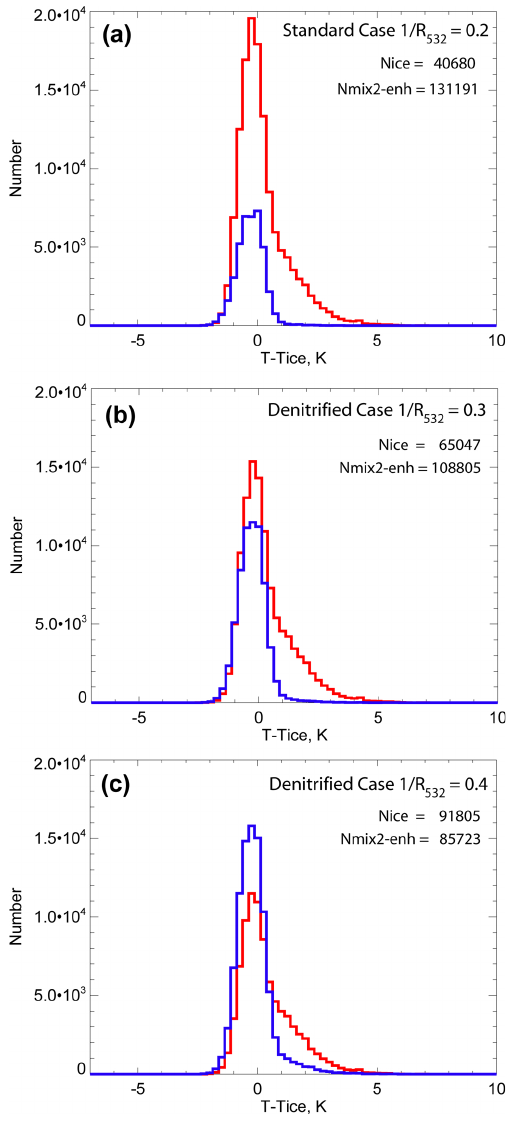
Fig. 12. PDFs of ice (blue) and Mix 2-enh (red) PSC observations in the 75–90 ◦ S equivalent latitude band for August 2009 as a function of T − T ice using an ice/mix 2-enh boundary of (a) 1 /R 532 = 0 . 2, (b) 1 /R 532 = 0 . 3, and (c) 1 /R 532 = 0 .